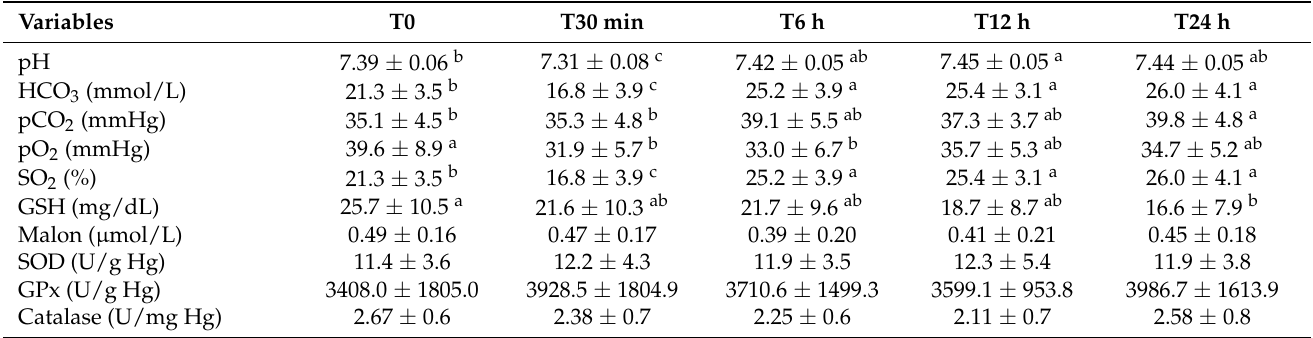
Table 2. Blood gas, lipid peroxidation, and oxidative stress variables of sheep following acute blood